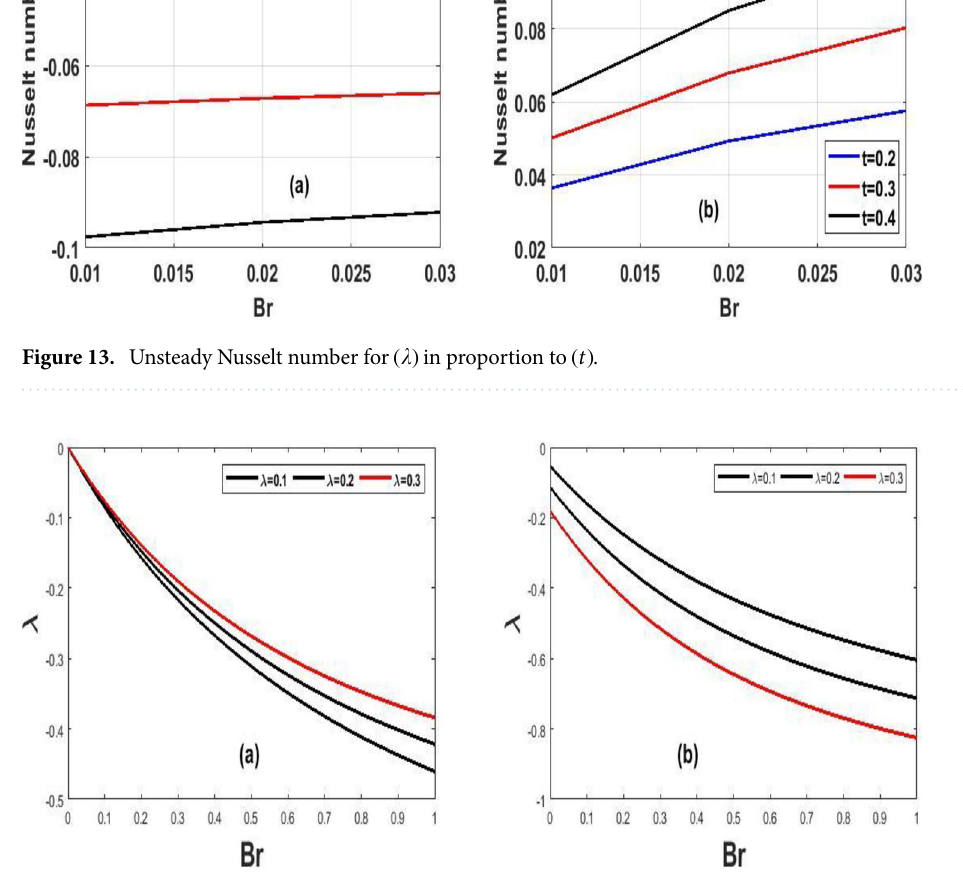
Figure 14. Steady state Nusselt number for ( Br ) against ( (cid:31) )